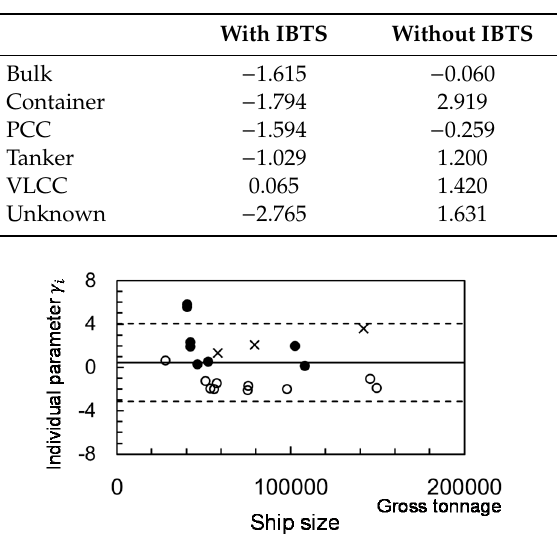
Figure 12. Relationship between ship size and individual parameters. Opened and closed circles are plots for vessels with IBTS and without IBTS, respectively. Cross symbols are plots for vessels for which information on the install of IBTS was unavailable. Solid line is mean of individual parameters, and dashed lines are upper and lower limits of 90% confidence